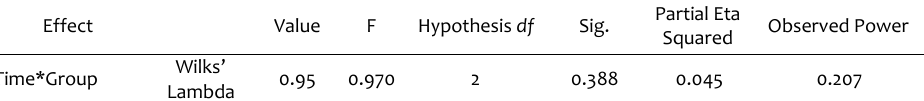
Table 1. Multivariate tests results